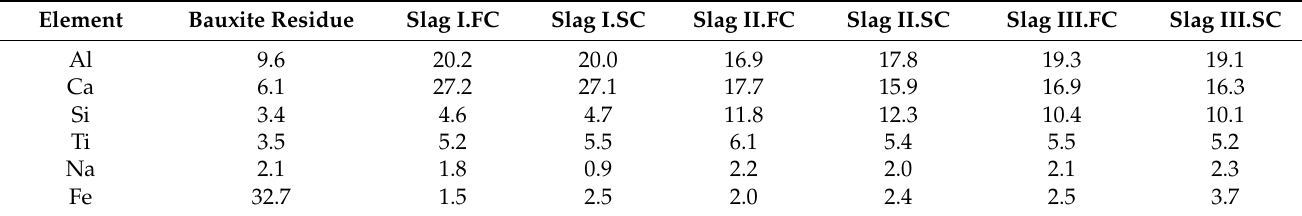
Table 3. Chemical composition of red mud and the slag samples * from reduction smelting analyzed by [60], where slag I was obtained by 20% CaO addition, and slags II and III were obtained by CaO and SiO 2 addition, respectively, wt.%. (reproduced from Ref.